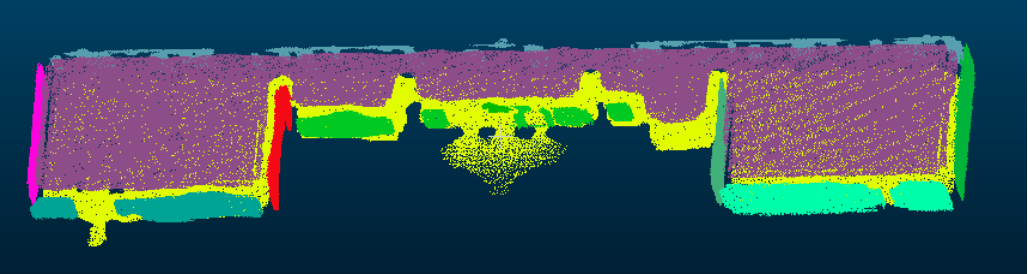
Figure 16. Scenario 2 Wall Clusters.